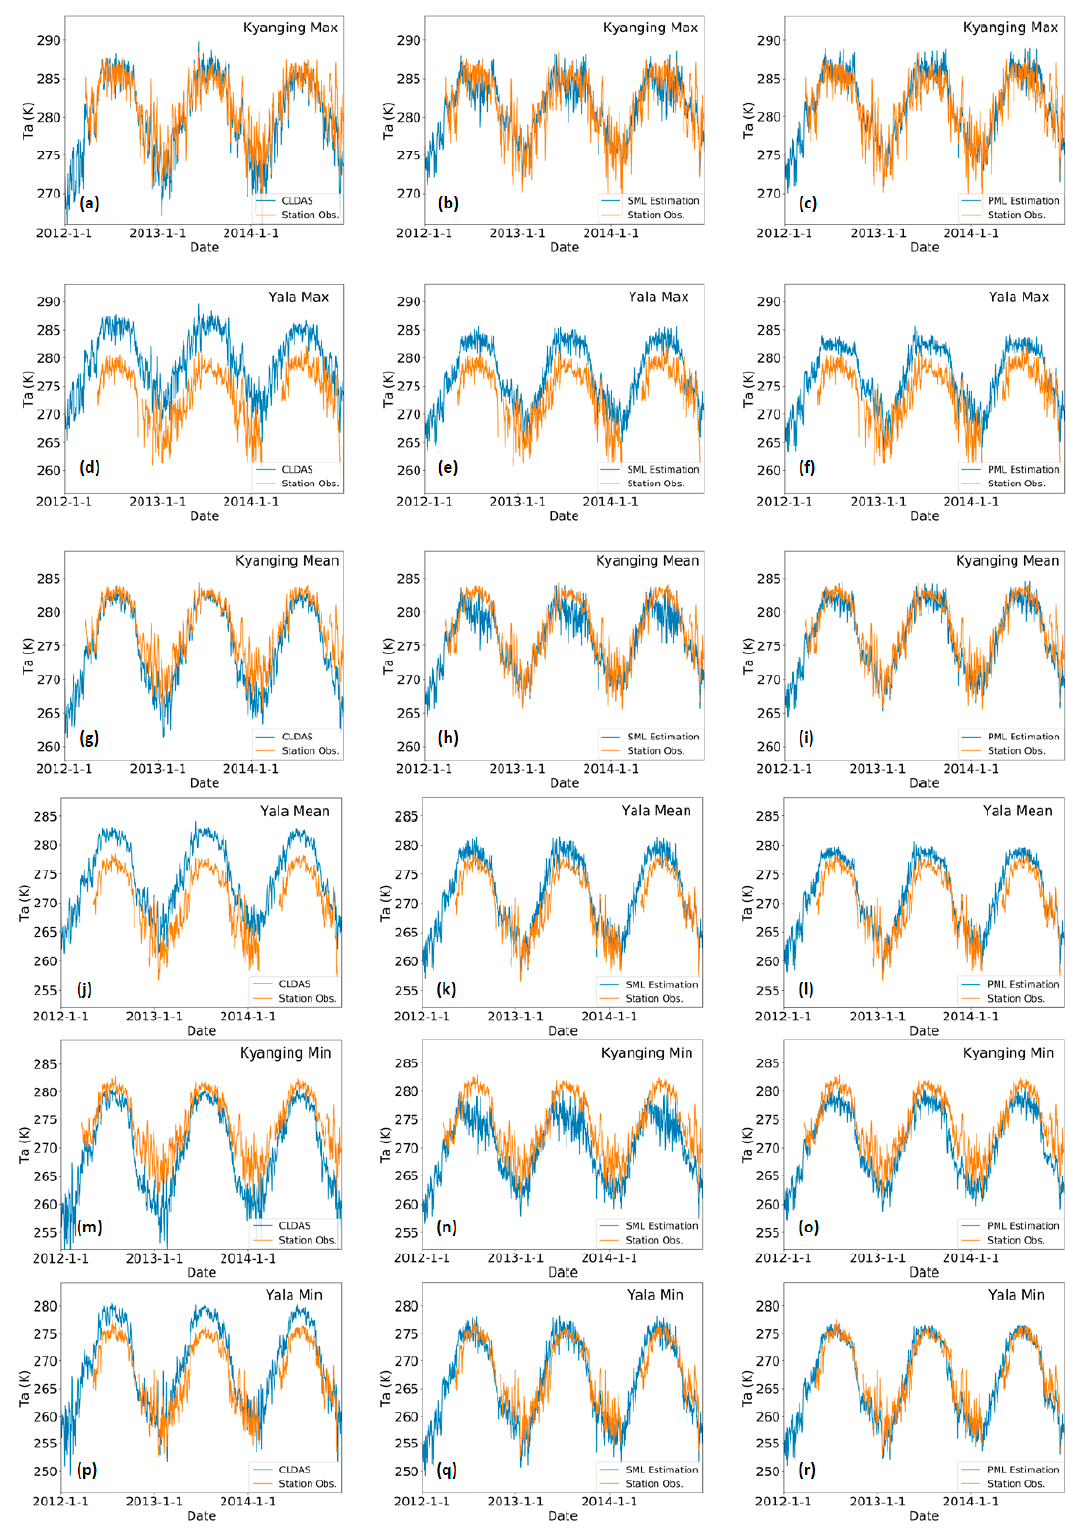
Figure 8. Time serial comparison between station observed Ta (yellow line) and estimates (blue line) from the: CMDAS ( left ); SML ( center ); and PML methods ( right ). ( a – c ) and ( d – f ) are for daily maximum air temperature at the Kyanging and Yala stations, respectively. ( g – i ) and ( j – l ) are for daily mean air temperature at the Kyangjing and Yala stations, respectively. ( m – o ) and ( p – r ) are for daily minimum air temperature at the Kyangjing and Yala stations,